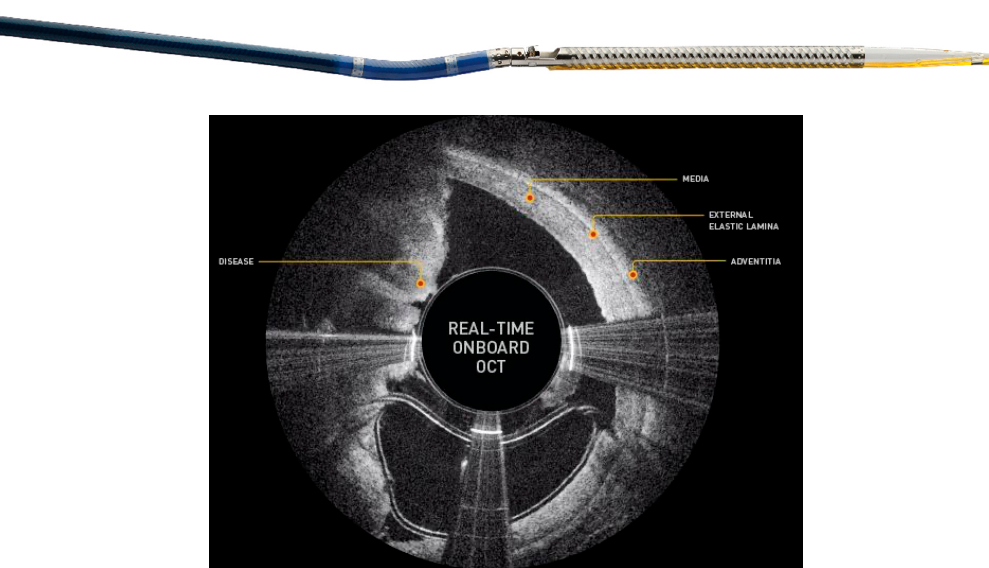
Figure 7. Pantheris System with Onboard OCT Guided Atherectomy. Courtesy of Avinger, Inc.